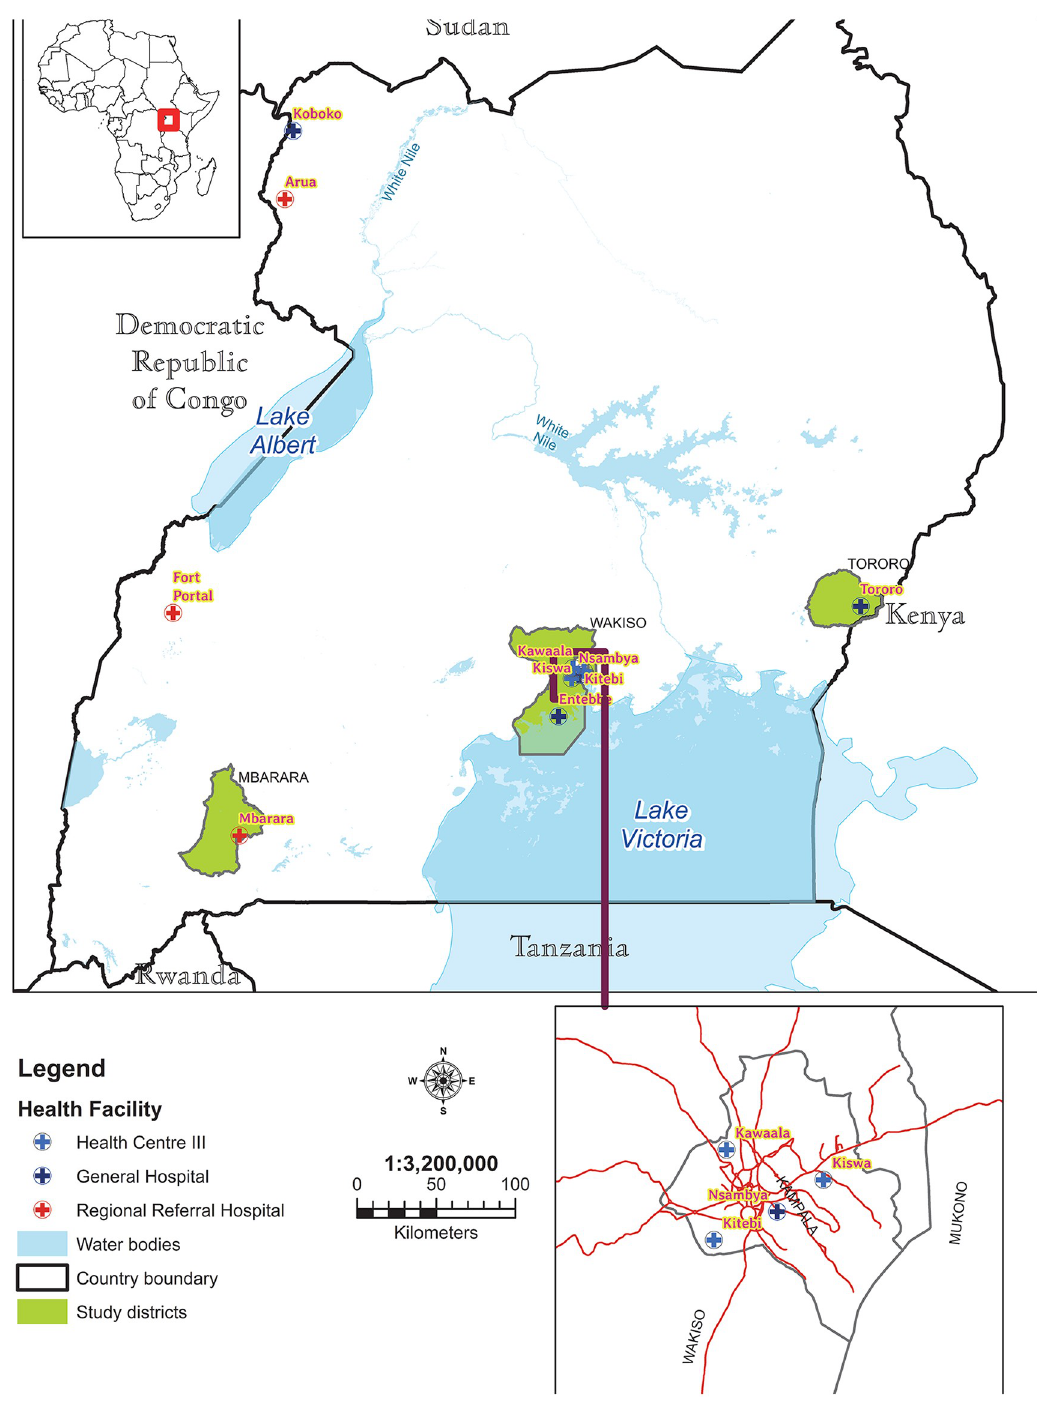
Fig 1. Map of Uganda showing the location of the study